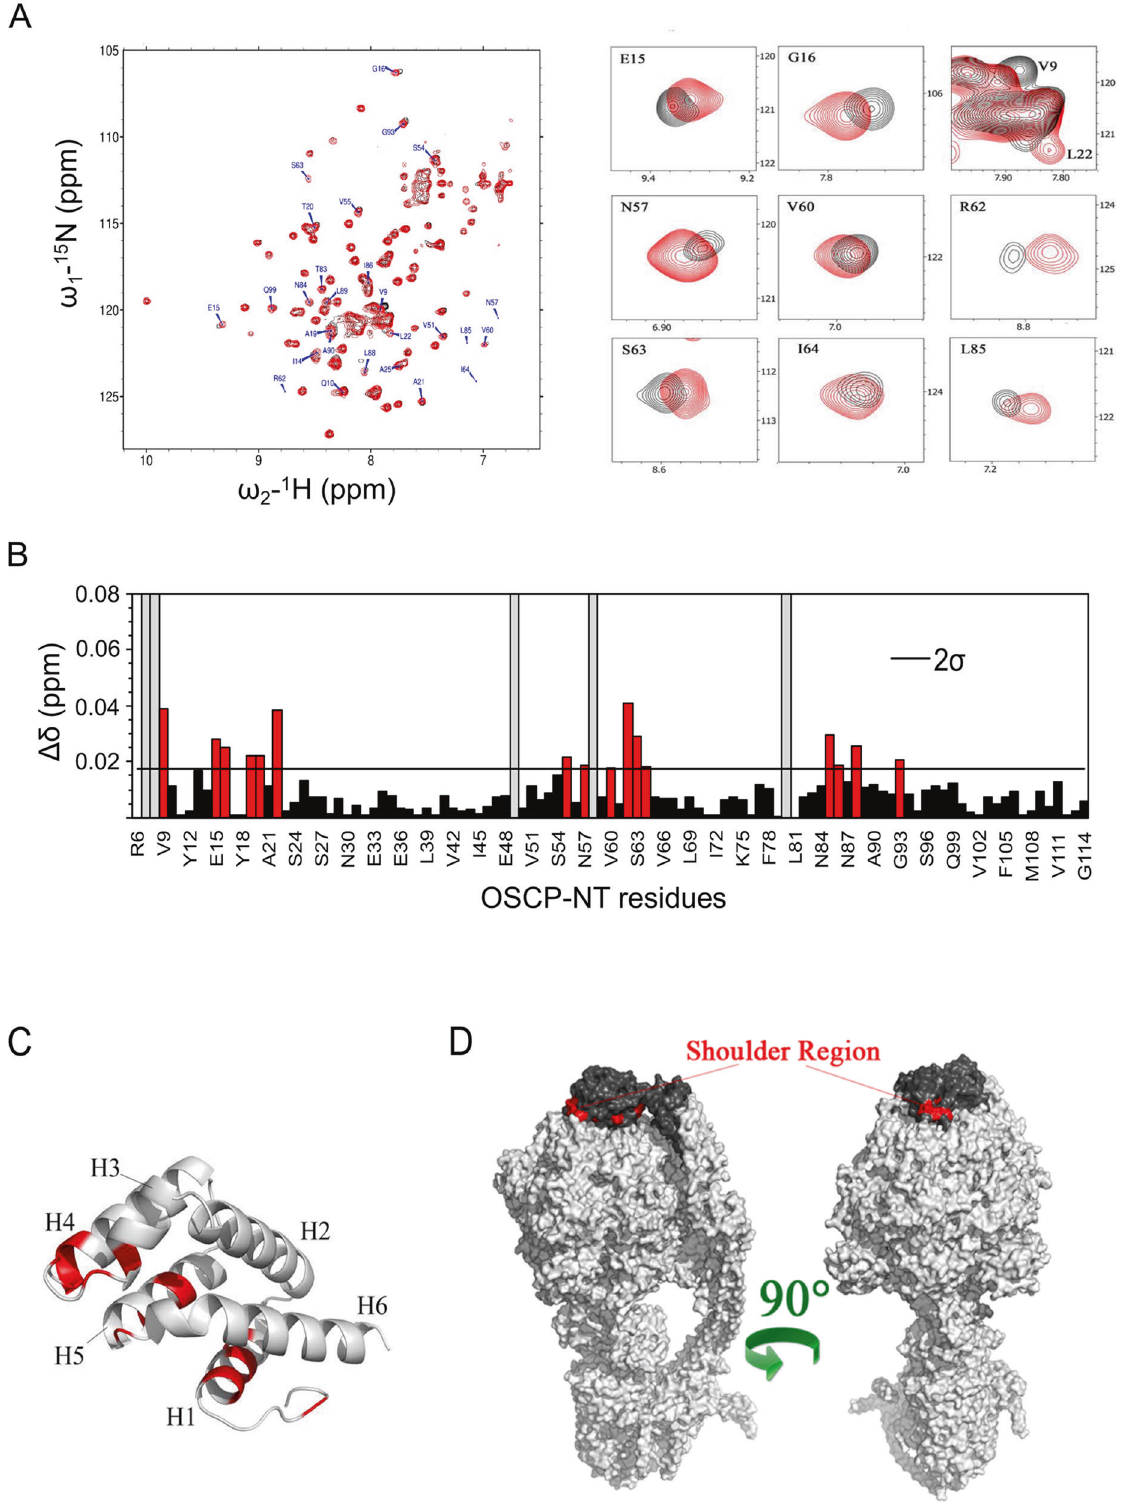
Fig. 4 NMR studies revealed the binding region of IF1-NT on a portion of the shoulder region of OSCP, which remains accessible also when OSCP is within the ATP synthase. A 1 H- 15 N SOFAST-HMQC spectrum of OSCP-NT (residues R6-G114) in the absence (red) and in the presence (black) of a 20-fold molar excess of unlabeled IF1-NT (residues G1-E40). The cross peaks with pronounced chemical shift perturbation are labeled and some of them are represented in the expanded plots on the right. B Combined chemical shift perturbations derived from the experiments shown in A . Red bars indicate residues showing a deviation larger than 2 standard deviations (2 σ ) calculated for all residues. C Cartoon representation of OSCP-NT showing in red the residues with the largest chemical shift perturbation ( Δδ >2 σ ). D Surface representations of the cryo-EM structure of Sus scrofa ATP synthase (PDB code 6J5J) showing two different orientations. The OSCP subunit (both domains) is colored in black. Residues of OSCP-NT affected by the interaction with IF1-NT (with Δδ >2 σ ) are colored in red. Only residues accessible on the surface of the protein are visible. The shoulder region between helices 3 and 4 is